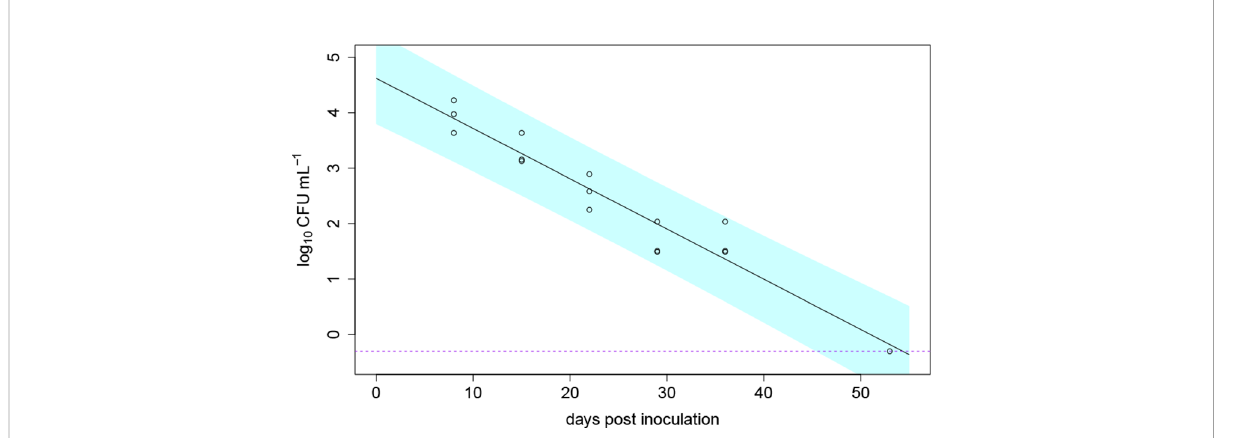
FIGURE 6 Die-off of Ralstonia solanacearum over time in in three pots fi lled with clay loam soil without the presence of a host plant; the data shown as open circle symbols were fi tted with a log-linear die-off model (solid line); the dashed purple line indicates the detection limit and the blue band indicates the 95% prediction interval; at the last measurement point 54 days post inoculation, the bacterium was only detectable in one of the three